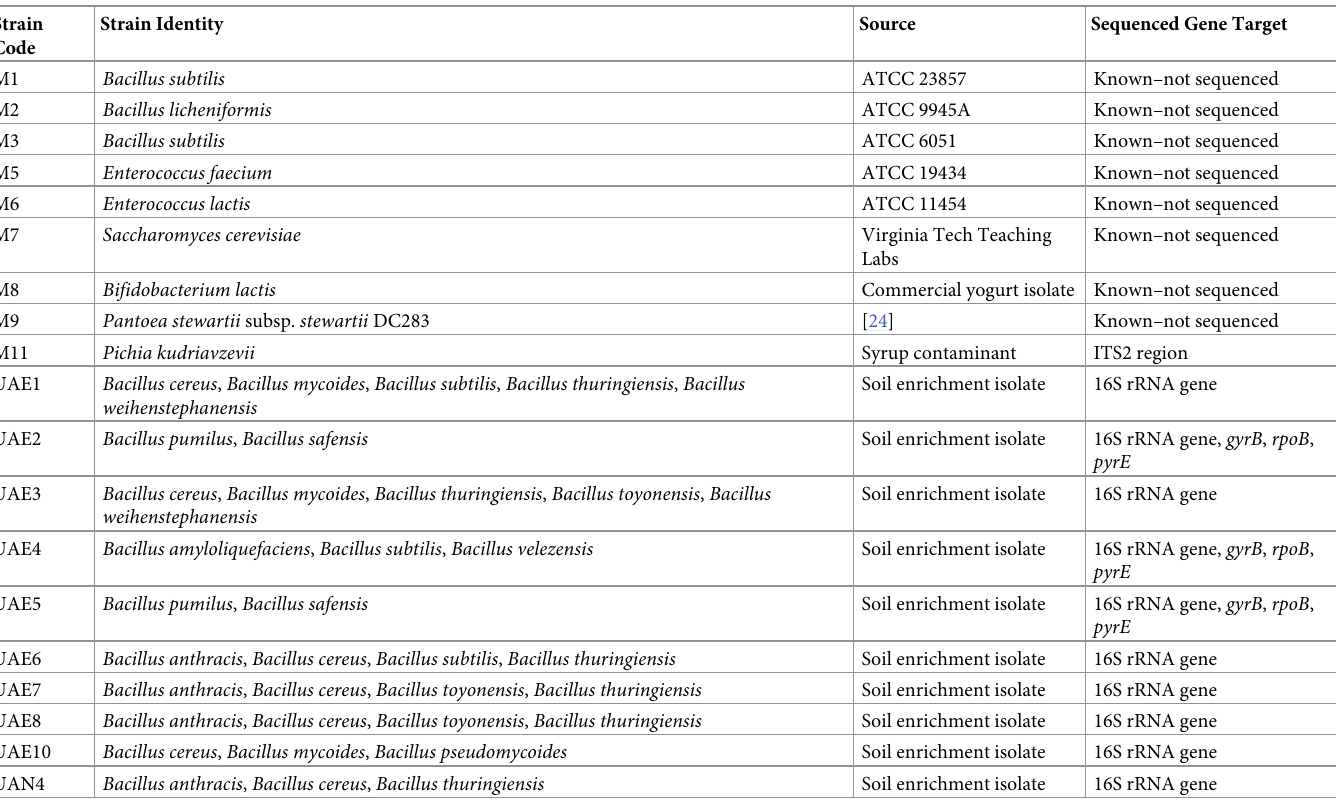
Table 2. Microbes used in this study a